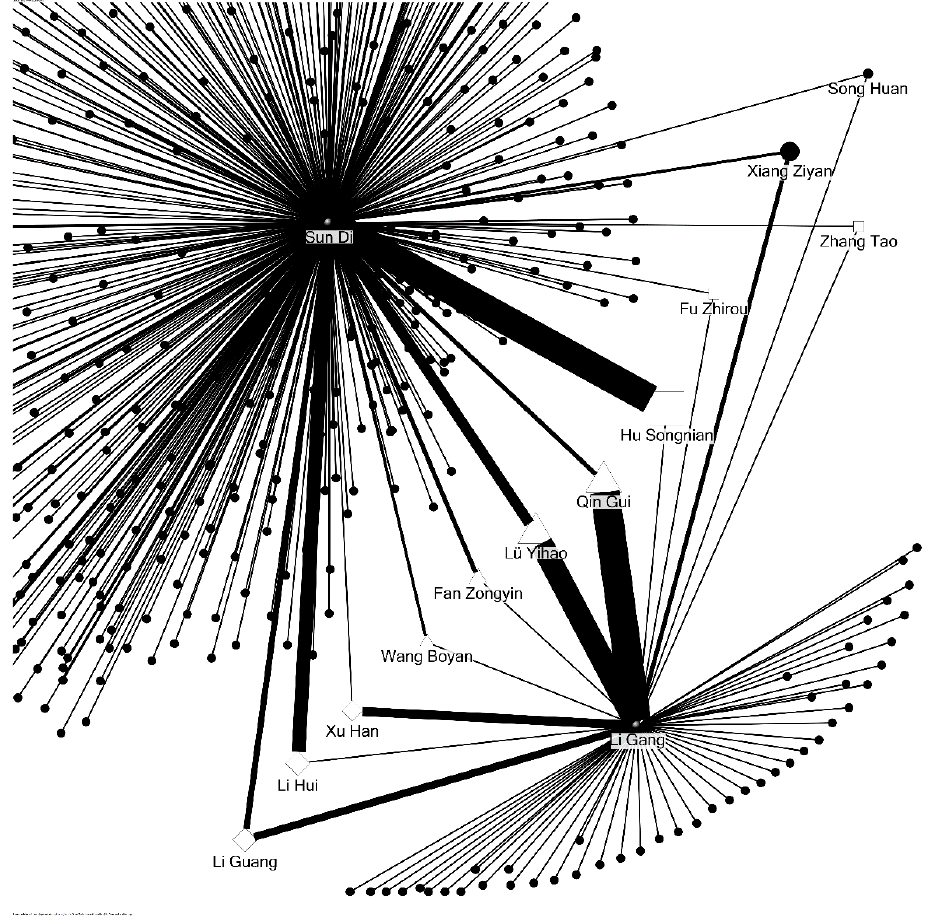
Figure 2. Common Correspondents of Sun Di and Li Gang. The shape of the nodes denotes the highest official position that the common correspondents of Li Gang and Sun Di reached in the Song civil service. (Triangle = chief councilor; diamond = assistant councilor; square = co‑administrator or signatory official of the Bureau of Military Affairs). The size of the nodes and the thickness of the edges represents the number of letters that Li Gang and Sun Di sent.